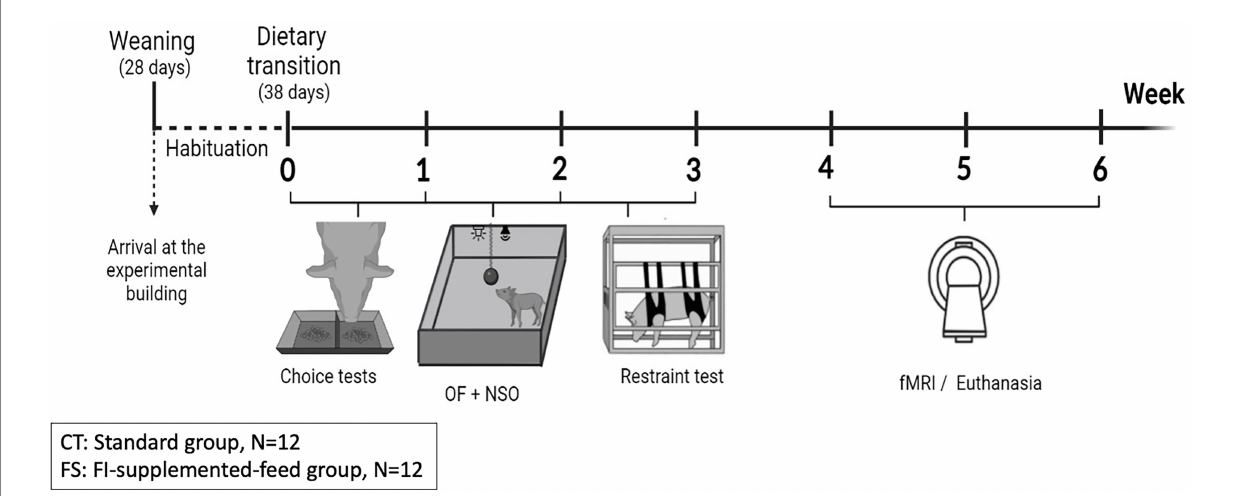
FIGURE 1 Experimental design to study the effects of a functional food ingredient on feed consumption, preferences, as well as the behavioral and brain responses to acute stress. From their arrival in the experimental building, piglets had 10 days to get habituated to their new environment and to the first-age feed before a dietary transition toward second-age feed composed of different composition, granulometry and texture. The days after this dietary transition, two-choice food preference tests (choice tests) were conducted. Emotional reactivity to acute stress was evaluated through different behavioral tests: Open-field (OF), Novel suddenly moving object (NSO) and physical contention test (restraint test). Brain responses to the functional ingredient and the two different feeds’ odor, as well as to an acute pharmacological stressor (intravenous injection of Synacthen®) were investigated during Week 4 and 5 in habituated and naive animals. Pigs were euthanized after the functional magnetic resonance imaging (fMRI)